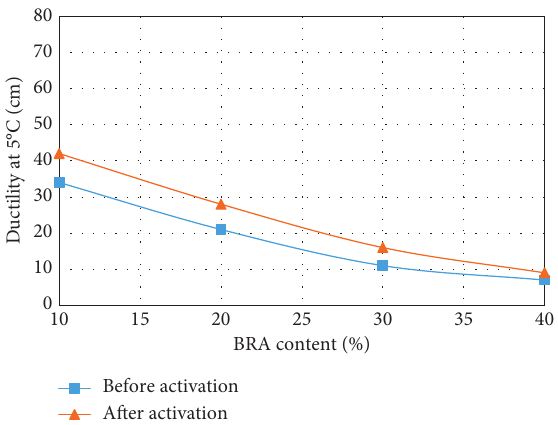
Figure 4: Map of ductility at 5 ° C of BRA-modified asphalt with dosage before and after